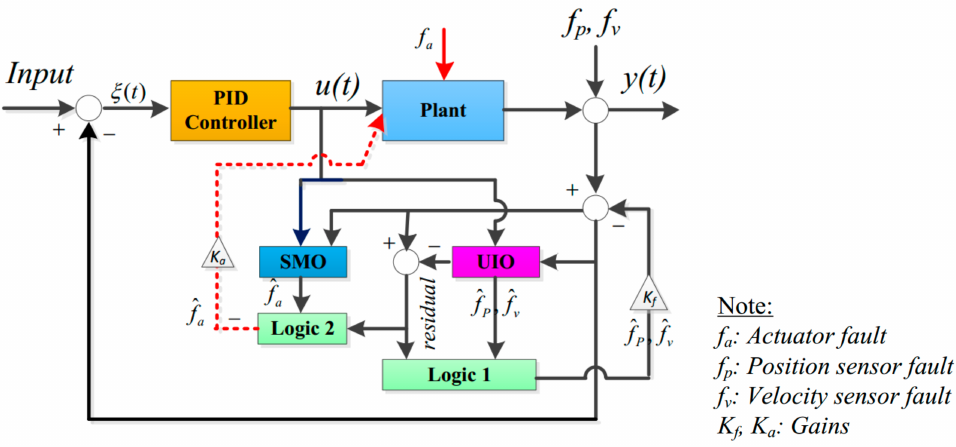
Figure 2. Scheme for fault-tolerant control based on actuator and sensor fault